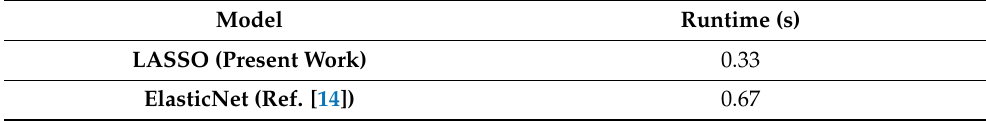
Table 2. LASSO and ElasticNet time